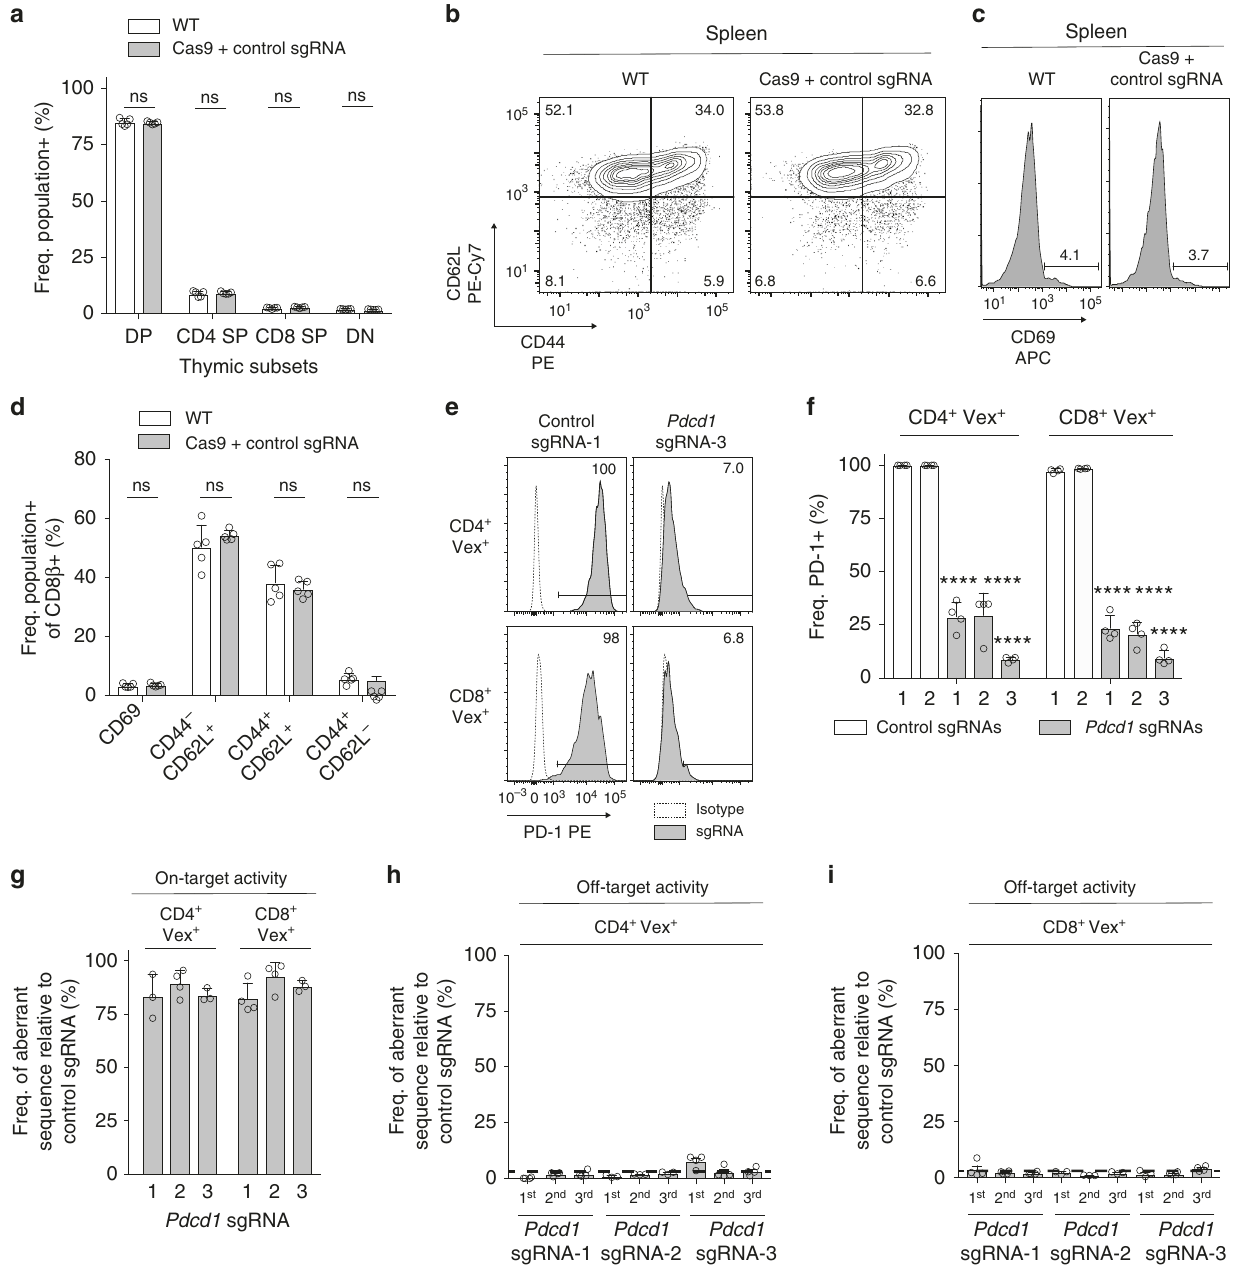
Fig. 2 Deletion of genes in naive T cells with minimal off-target editing using CHIME. a Quanti fi cation of thymic subsets (CD4 – CD8 – , CD4 – CD8 + , CD4 + CD8 – , CD4 + CD8 + ) from WT or Cas9 + control sgRNA chimeric mice. b Representative fl ow cytometry plots of CD44, CD62L, and c CD69 from splenic CD8 + T cells. d Quanti fi cation of naïve status of CD8 + T cells in ( b , c ). e Flow cytometry plots of PD-1 expression in CD4 + T cells (top panel) and CD8 + T cells (bottom panel) from representative non-targeting control sgRNA or Pdcd1 sgRNA chimeras following α CD3/CD28 stimulation. f Quanti fi cation of PD-1 expression for two control and three Pdcd1 sgRNAs from ( e ). g TIDE assay on naïve CD4 + and CD8 + T cells for three Pdcd1 targeting sgRNAs. h , i TIDE assay on naïve ( h ) CD4 + and ( i ) CD8 + T cells designed to detect the top three predicted off-target sites (1st, 2nd, 3rd) for three Pdcd1 targeting sgRNAs. Dashed line represents the aberrant sequence (%) when comparing two non-targeting control sgRNAs (background aberrant sequence). All experiments had at least three biological replicate animals per group and are representative of two independent experiments. Bar graphs represent mean and error bars represent standard deviation. Statistical signi fi cance was assessed among the replicate bone marrow chimeras by one-way ANOVA ( a , d , f ) (* p < .05, ** p < .01, *** p < .001, **** p < .0001). See also Supplementary Fig. 2. Source data are provided as a source data fi